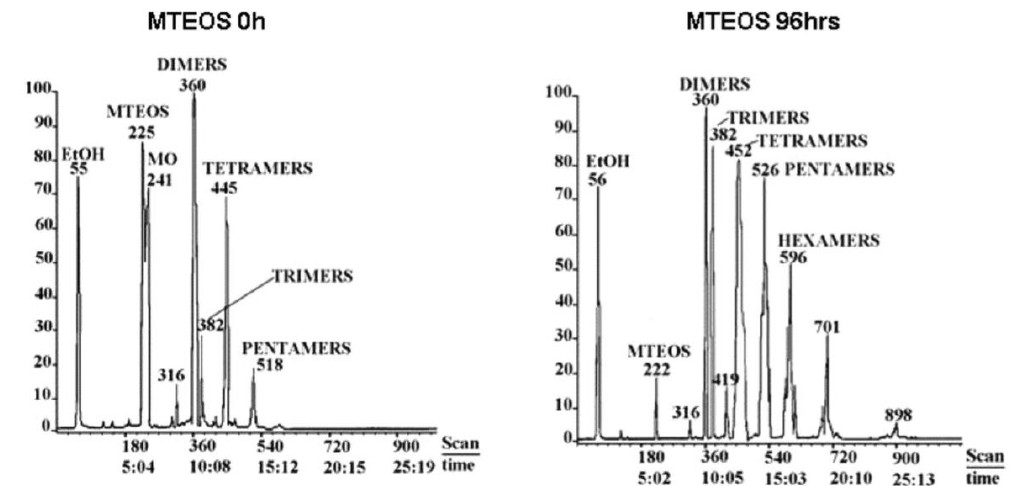
Figure 25. The GC/MS chromatograms of methyl triethoxysilane and its species in the presence of alcohol, water, and HCl. Reprinted with permission from [10]. Copyright John Wiley and Sons, 2016.